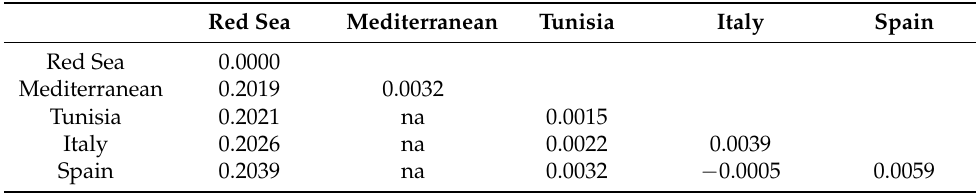
Table 4. Pairwise nucleotide p-distances for the COI sequences of Holothuria (Thymiosycia) impatiens . The mean within = group (diagonal) and net average between-groups (below diagonal) divergence. Na: not applicable. Statistically significant pairs shown in bold ( p <